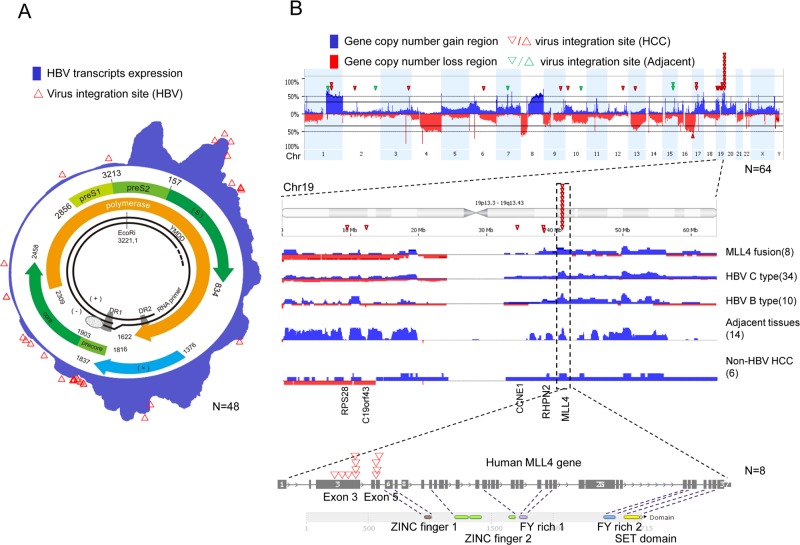
Genome landscape of HCC and related HBV.RNASeq and aCGH data in HCC tissues were analyzed. (A) Model of the HBV genotype C genome, including the well-known HBV genome within the circle, and HBV mRNA expression [blue area] and integration sites [red triangle]. (B) HCC genomic landscape by HBV integration. The gene copy number gain is shown in blue, the copy number loss in red, and the human genome sites involved in virus integration at each chromosome as a red triangle.